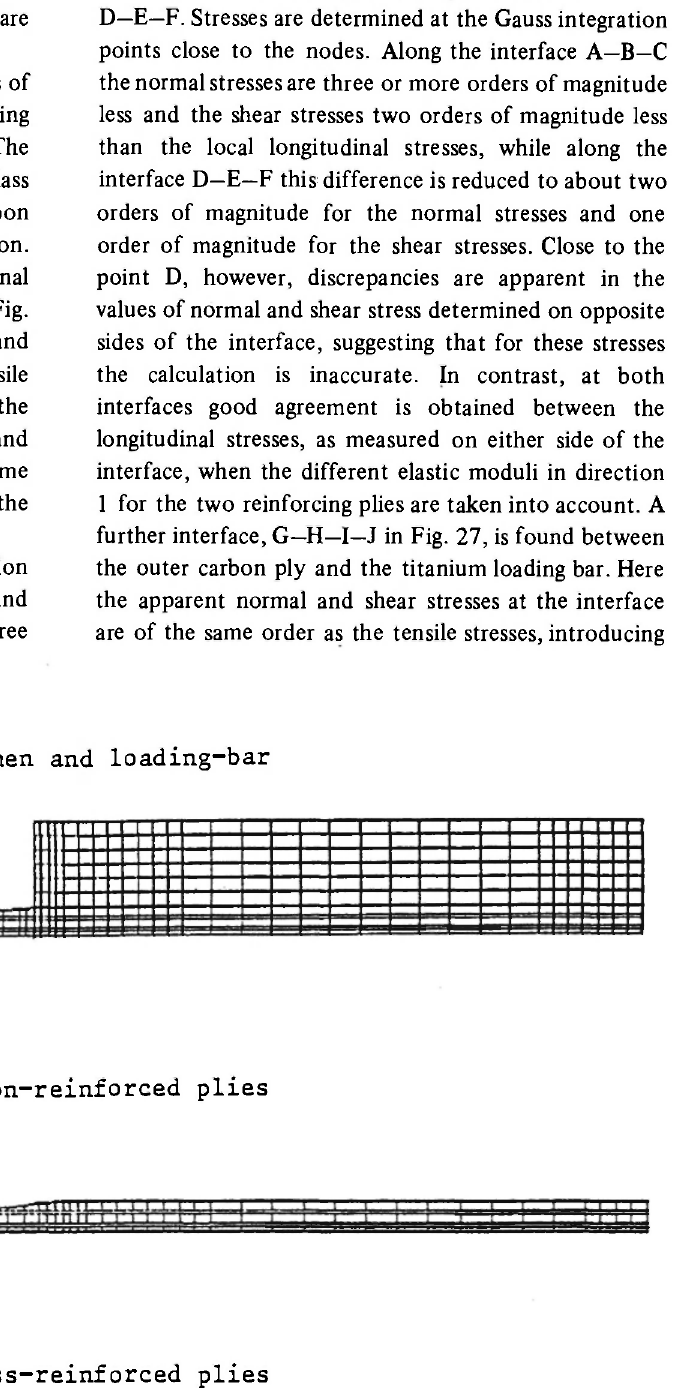
Fig. 26: Finite element mesh for hybrid carbon/glass tensile specimen; (a) specimen and loading-bar; (b) carbon-reinforced plies; (c) glass-reinforced